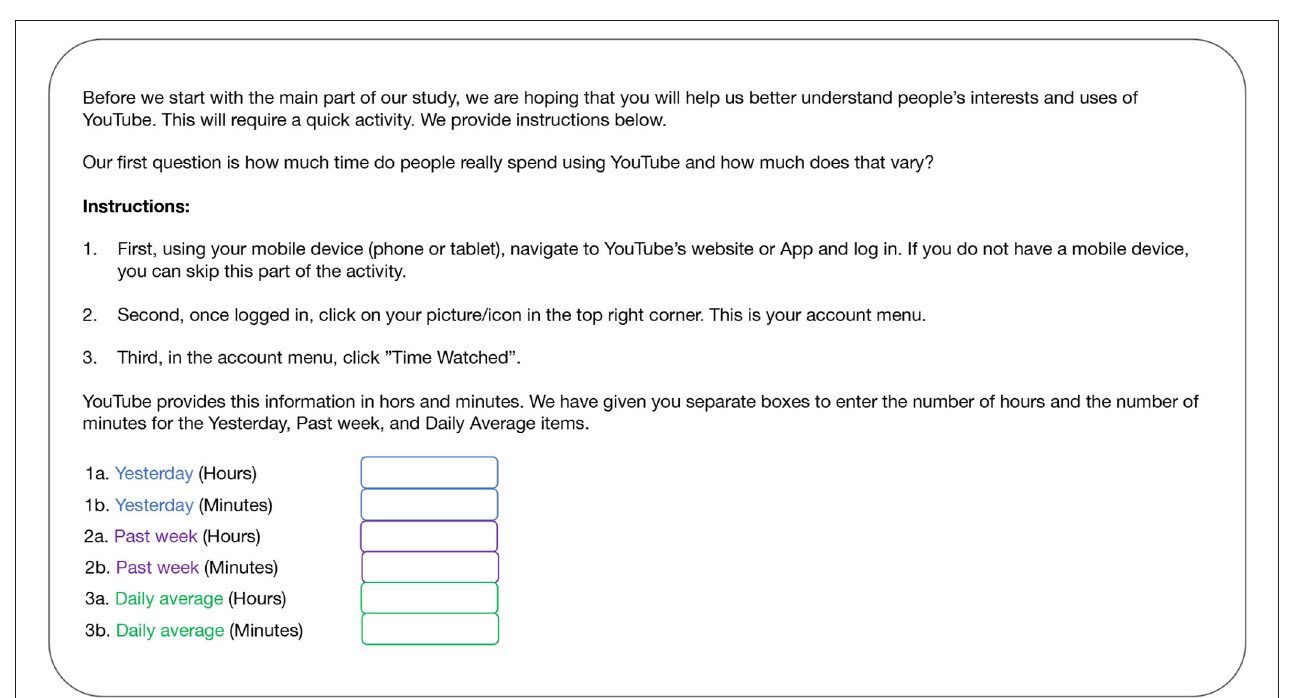
FIGURE 1 | Instructions for reporting YouTube “Watch Time” metrics. Participants for Survey 2 also saw these